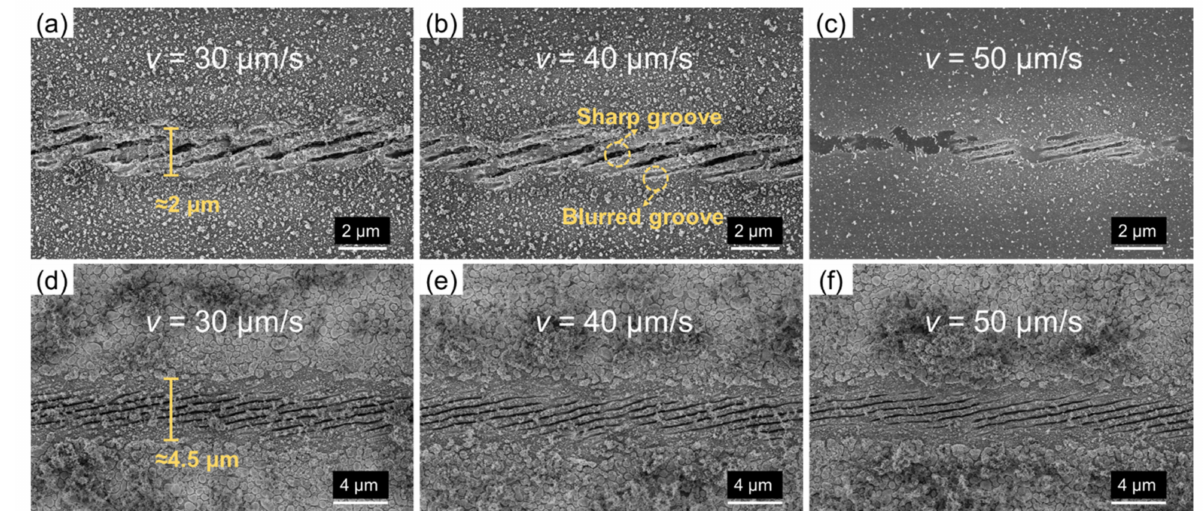
Figure 3. SEM images of the surface morphologies written on samples. ( a – c ) correspond to morphologies of bare silicon with different scanning speeds at a fixed laser fluence of 1.02 J/cm 2 . ( d – f ) correspond to morphologies of BiIn-Si with different scanning speeds at a fixed laser fluence of 2.55 J/cm 2 . The scanning speeds were 30, 40, and 50 µ m/s, as labeled on the